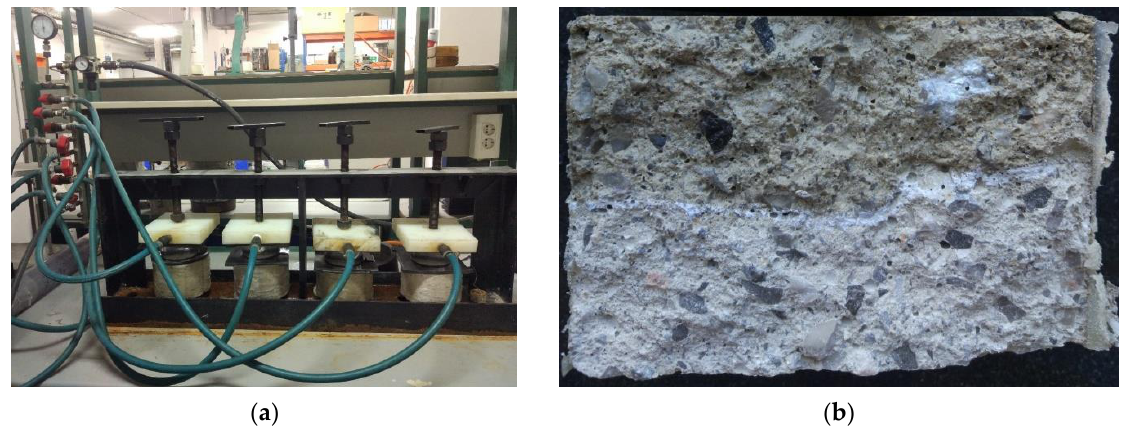
Figure 7. ( a ) Water permeability test layout. ( b ) Example of the moisture trace after the water permeability test.